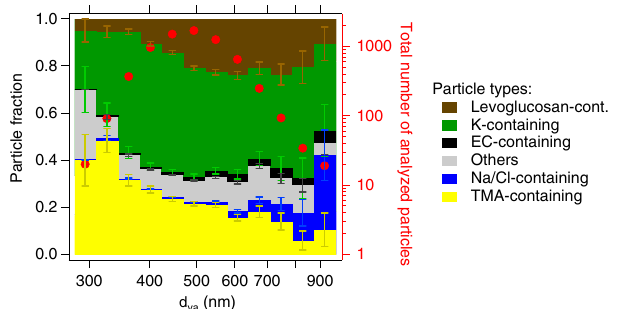
Figure 5. Cumulative size-resolved aerosol composition of the identified particle types (normalized to the total number of parti- cles analyzed by the ALABAMA (indicated by red dots)): TMA- containing (yellow), Na / Cl-containing (blue), EC-containing (black), levoglucosan-containing (brown), K-containing (green) and others (gray). The errors associated with number fractions of the identified particle types were calculated using binomial statis- tics.